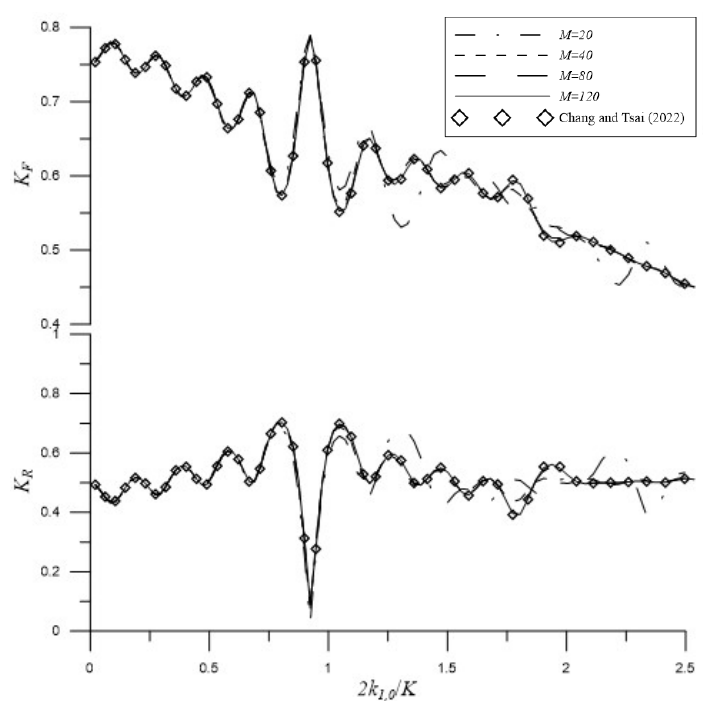
Figure 5. Variation of wave reflection and dimensionless wave force varying against 2 k 1,0 / K for the constructive Bragg scattering by four periodic half-cosine-shaped breakwaters placed near a partially reflecting wall [39].